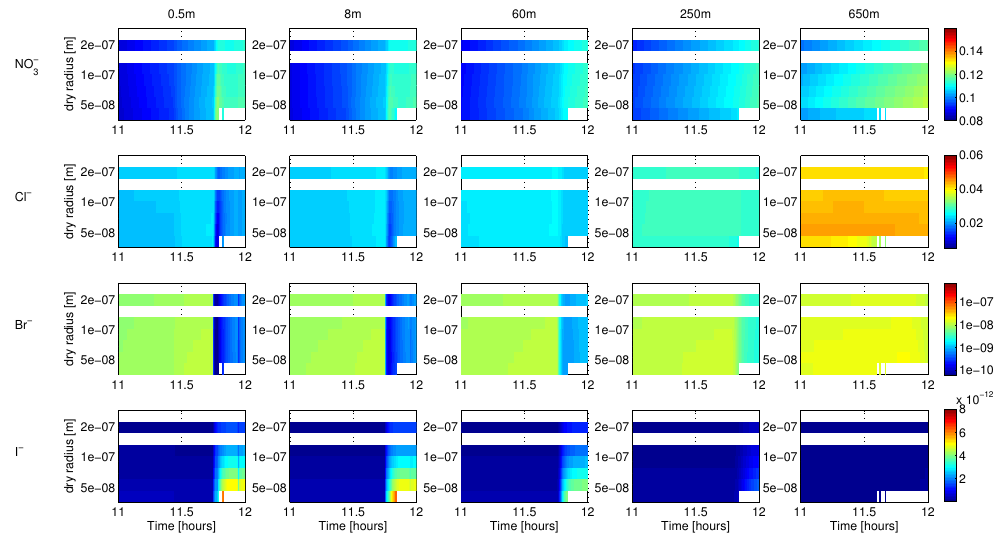
Fig. 8. Non-seasalt compositional data at different levels through the model column for the base case, low tide, model run. First, second, third and fourth rows are NO − , Cl − , Br − and I − dry mole fractions, respectively. 3